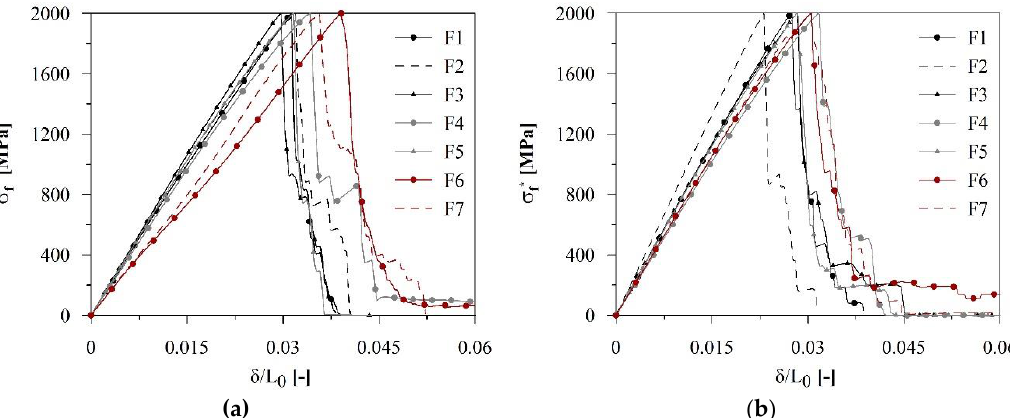
Figure 15. Fabric average tensile responses in terms of fabric stress on effective filaments σ f* vs. normalised displacement in the warp directions ( a ) and in the weft directions ( b ).